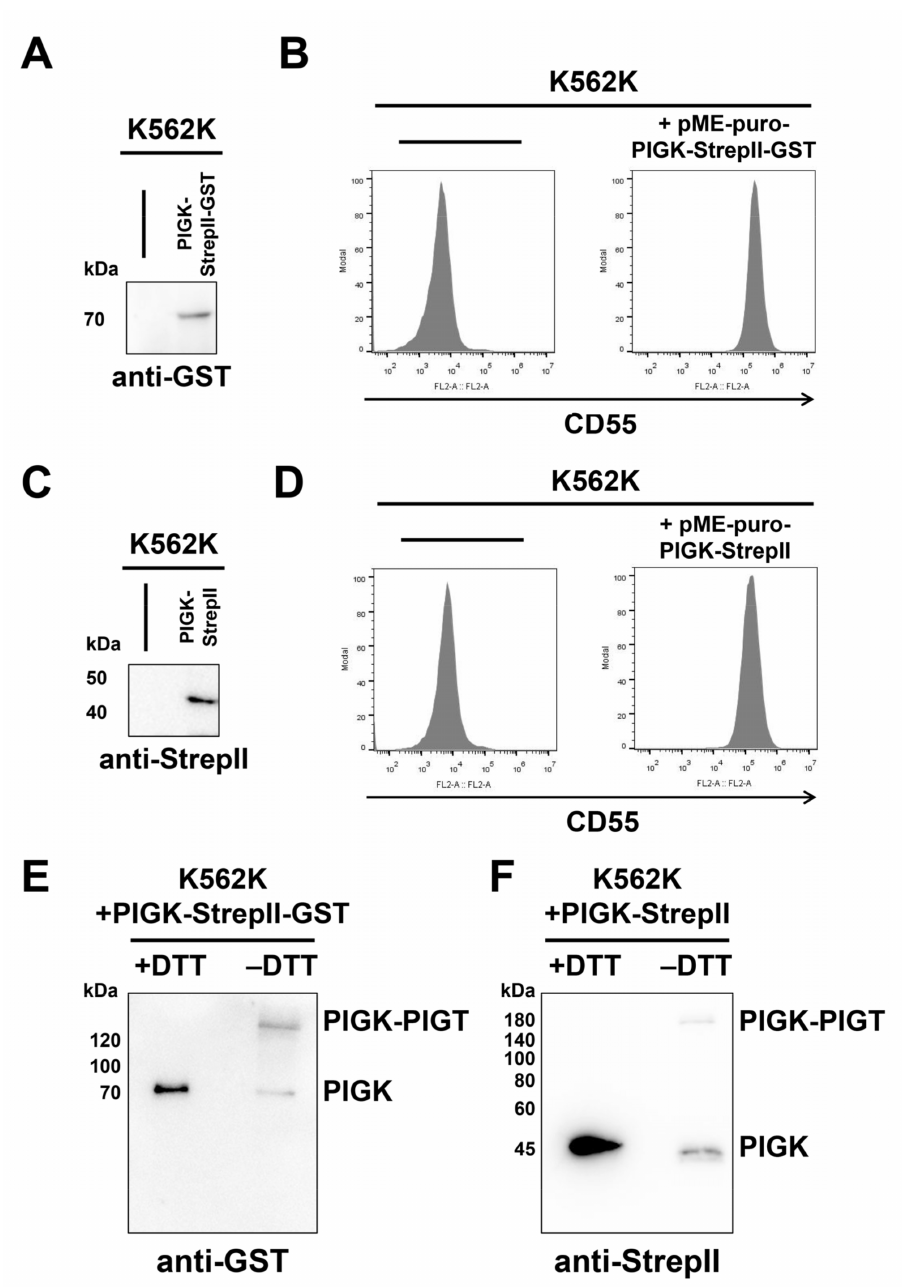
Figure 5. Establishment of cells for GPI-TA purification. ( A , B ) K562 PIGK -KO (K562K) cells